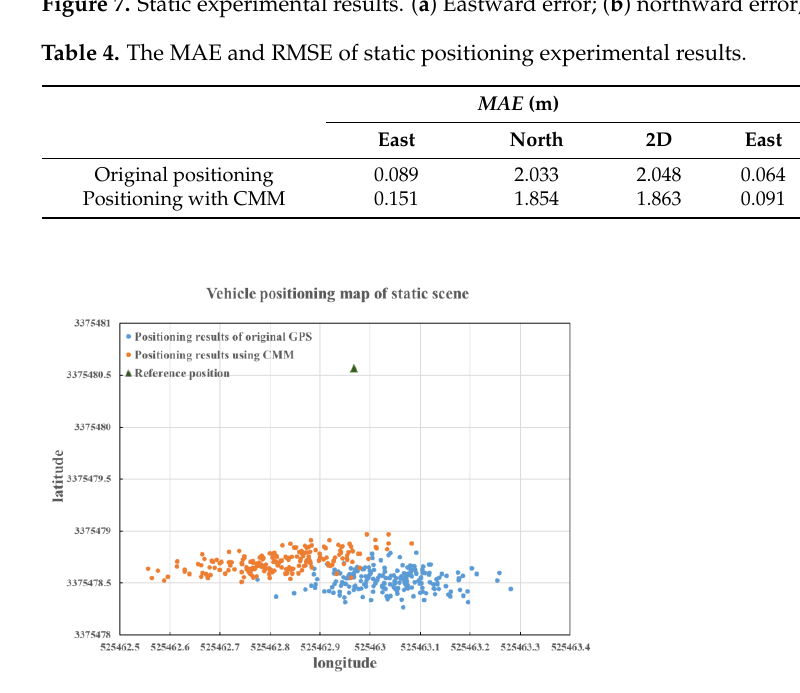
( b ) Figure 9. The CDF and PDF of 2D static positioning error. ( a ) CDF; ( b ) PDF. It can be found from the CDF that the error corresponding to the confidence level of 95% is reduced from 2.3 m to 2 m. As can be seen from the PDF, the original static posi- tioning error is mainly distributed in the range of 1.8 m – 2.3 m, and most of the position errors with CMM correction are reduced to the range of 1.6 M – 2 m. The experimental results indicate that the CMM can effectively improve the position- ing accuracy in the static environment.